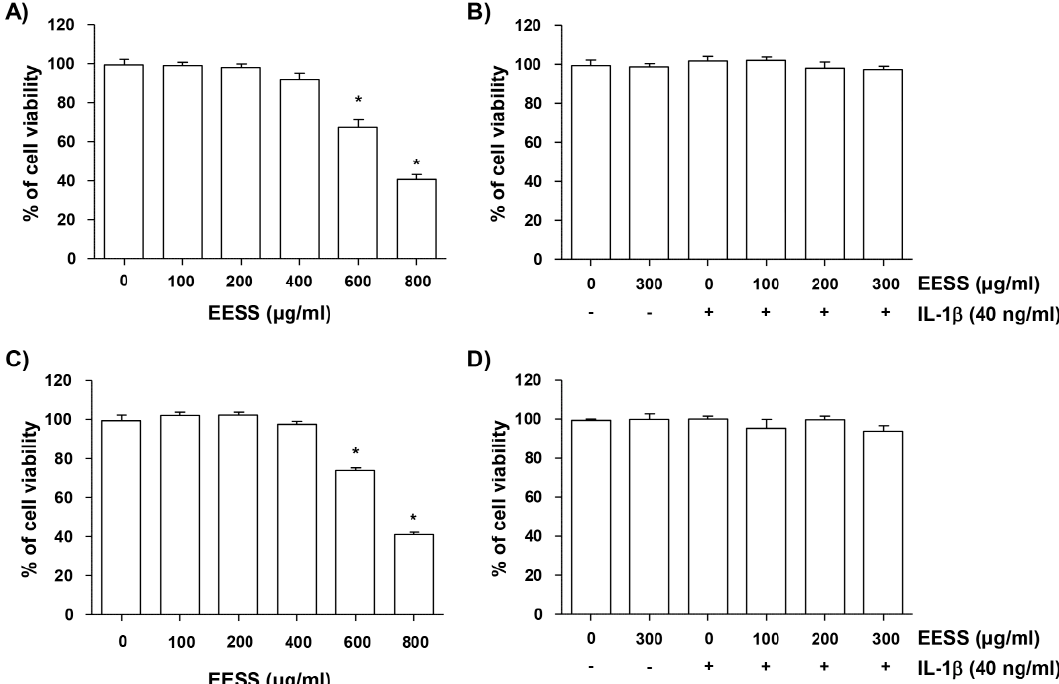
Figure 1. Effect of ethanol extract of S. serratifolium (EESS) and interleukin-1 β (IL-1 β ) on the cell viability of SW1353 and rat articular chondrocytes. SW1353 cells ( A , B ) and rat chondrocytes ( C , D ) were treated with various concentrations of EESS alone for 24 h ( A , C ), or pretreated with or without EESS for 1 h, before IL-1 β (40 ng/mL) treatment for 24 h ( B , D ). Cell viability was analyzed by 3-(4,5-dimethylthiazol-2-yl)-2,5-diphenyltetrazolium bromide (MTT) reduction assay. Data are expressed as the mean ± SD of three independent experiments. * p < 0.05 in comparison to the control group.